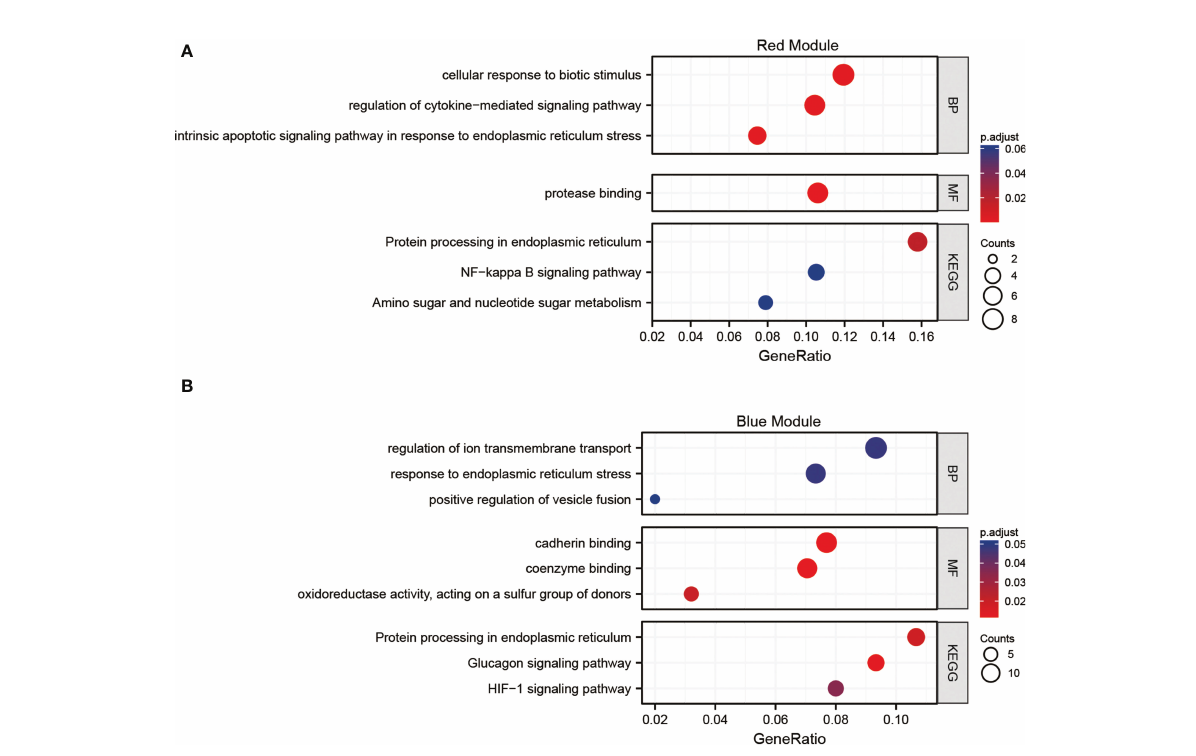
FIGURE 6 Functional analysis (A) Gene Ontology (GO) and Kyoto Encyclopedia of Genes and Genomes (KEGG) pathways enrichment of the red module of the weighted gene co-expression network analysis (WGCNA). (B) GO and KEGG pathways enrichment of the blue module of the